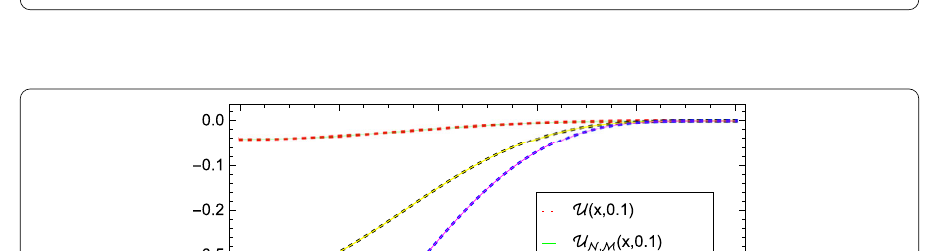
Figure 7 E V ( x , t ) of problem (3) with δ = 1.8, N = 10, M = 2